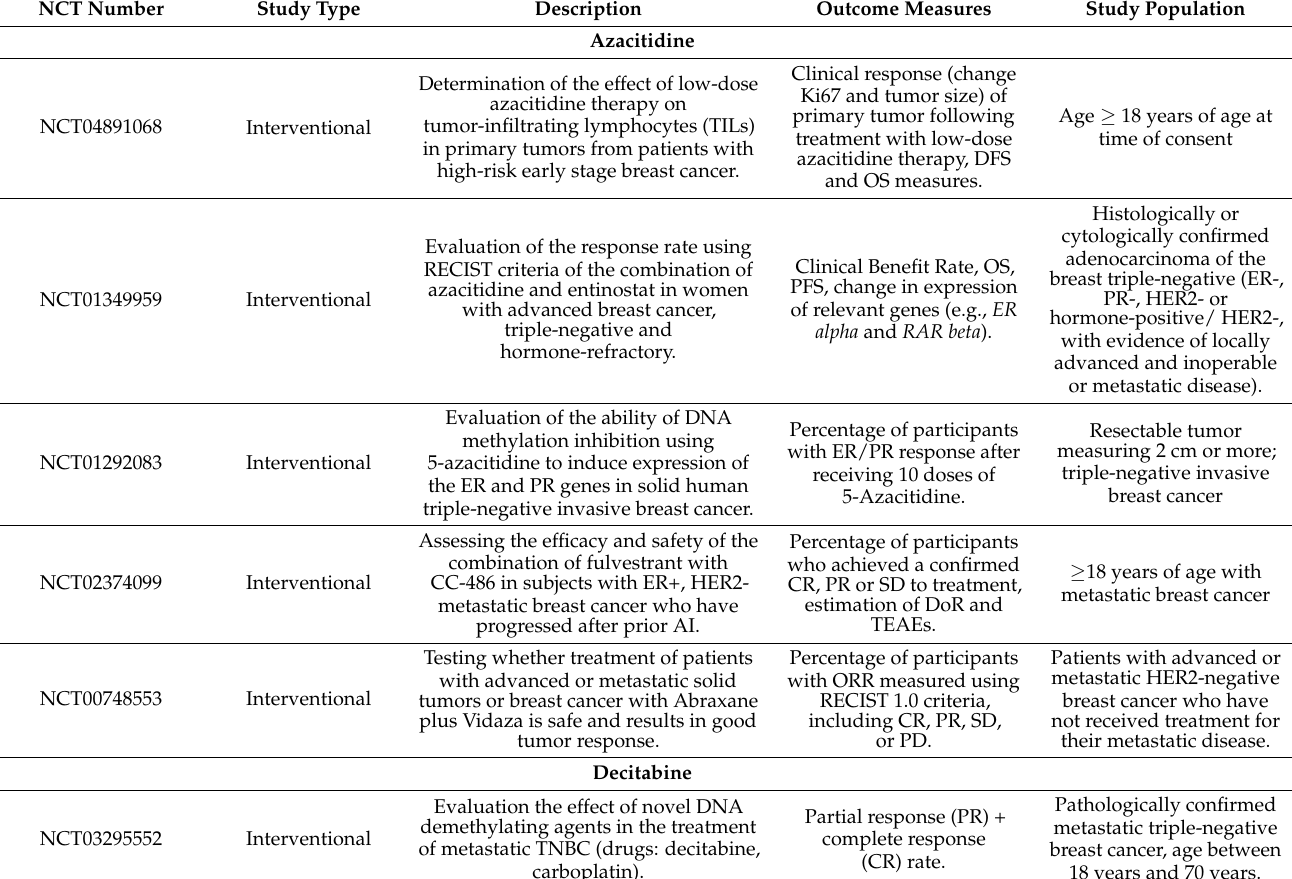
Table 1. Exemplary clinical studies on the role of methyltransferase inhibitors in breast cancer (based on ClinicalTrials.gov (accessed on 5 March 2023)